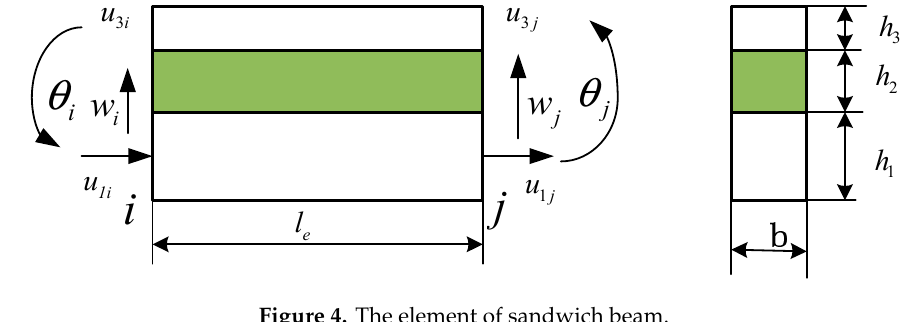
Figure 4. The element of sandwich beam.